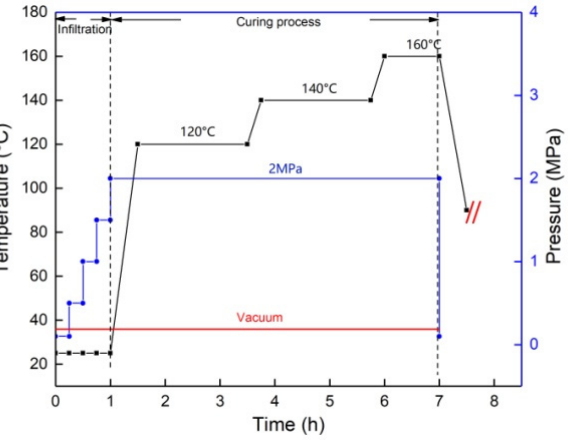
Figure 3. Process parameters and conditions for ex-situ liquid composite molding (LCM).